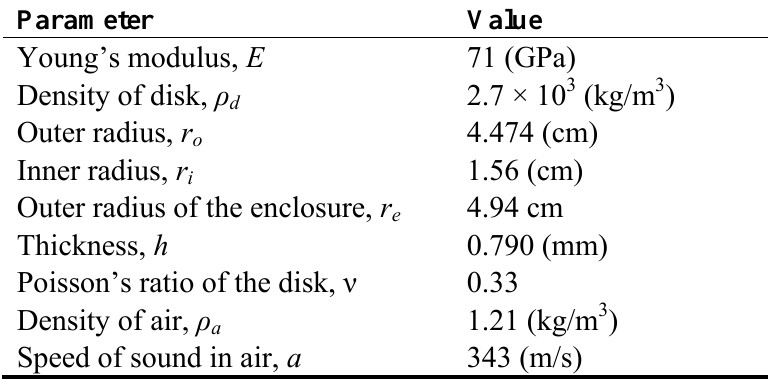
Table 1. Geometric and material parameters of the hard disk